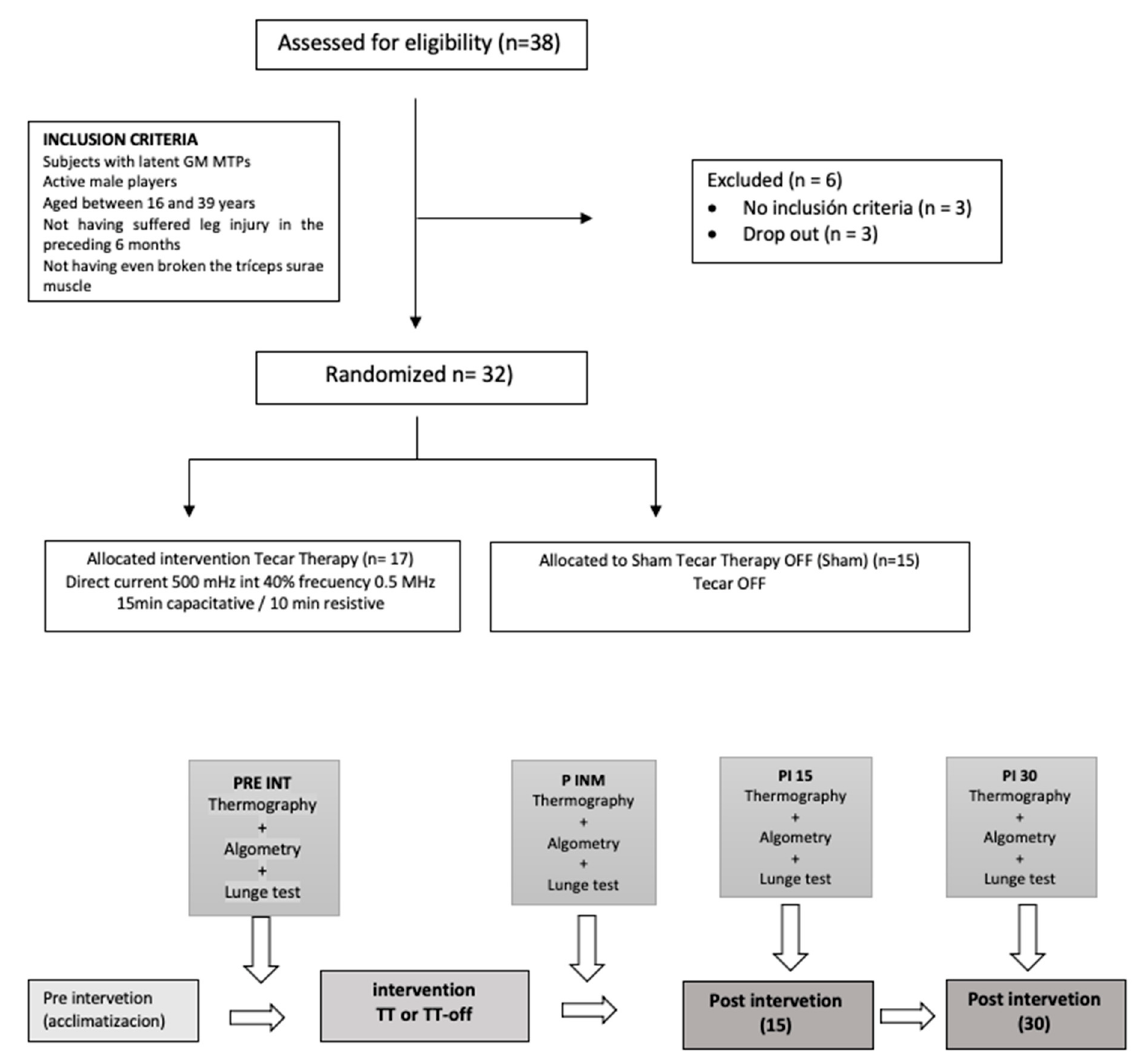
Figure 3. Flow diagram of the intervention procedure. Intervention process of the diathermy group and the Control Group. Prepared by the authors. (Latent GM MTP’s: Latent medial gastrocnemius myofasical trigger point; PRE INT: pre intervention; P INM: post immediately; P15: after 15 min intervention; PI 30: after 30 min intervention).